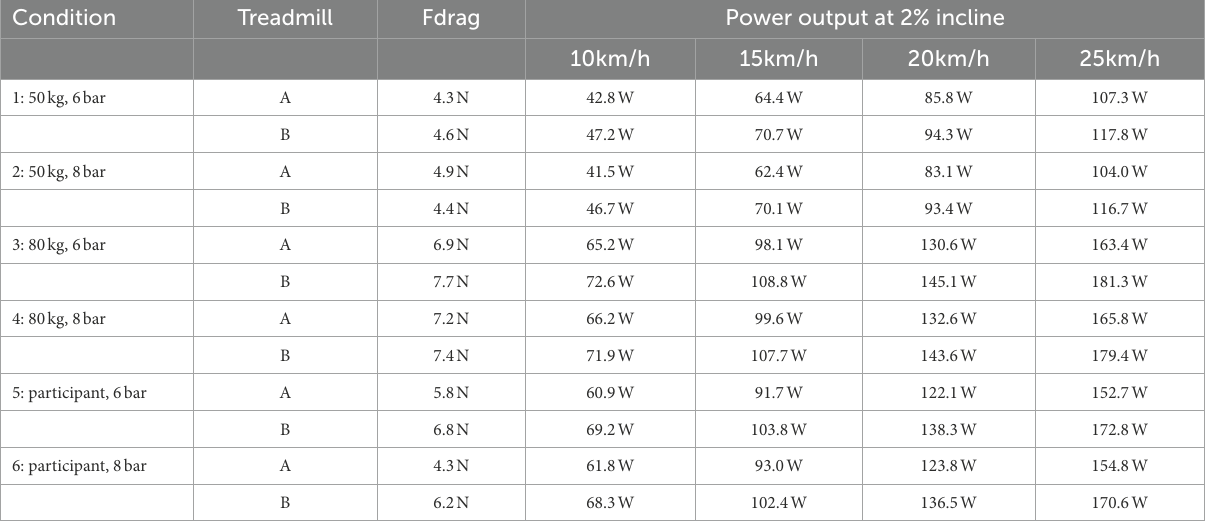
TABLE 4 Results of the drag test comparing both treadmills (A, B): calculated rolling resistance (Fdrag) at the level treadmill, and calculated power output at the conditions used during later exercise testing with athletes (inclination of 2%, speed of 10 km/h, 15 km/h, 20 km/h and 25 km/h).